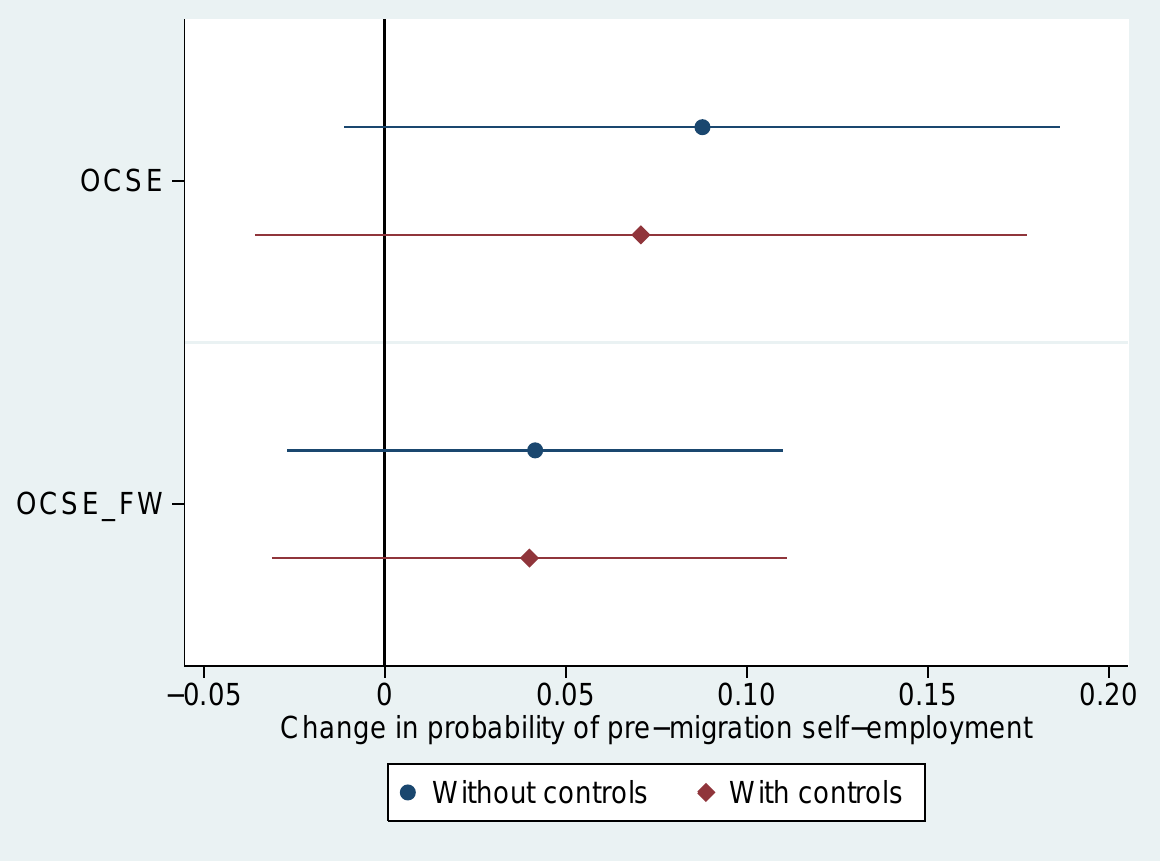
Figure 2: Predicting individual experience of self-employment before migration. Regression results with 95 percent confidence intervals (from robust standard errors) for a linear probability model of OCSE and OCSE_FW on individual experience of self-employment are shown. See Table S2 in the online supplement for full